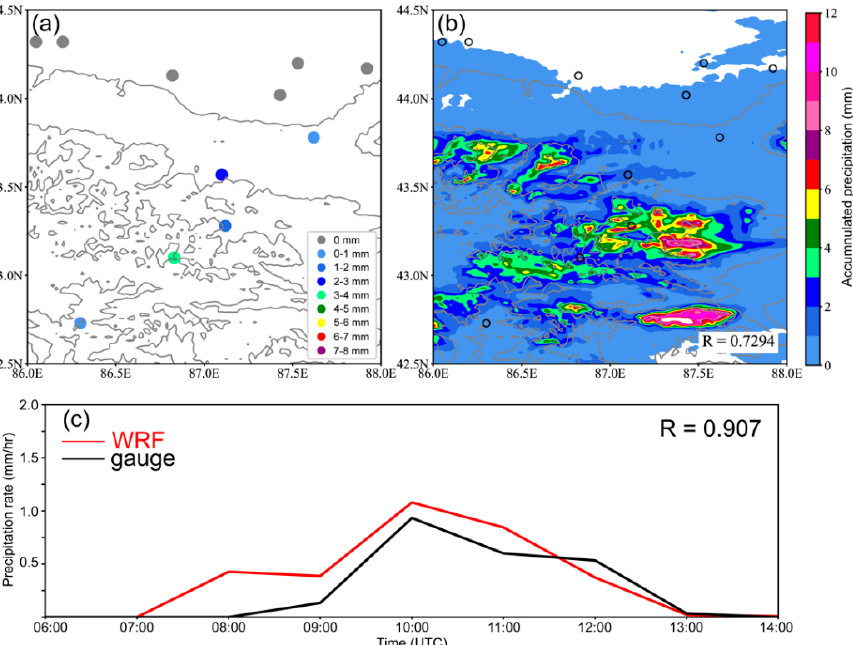
Figure 11. Map of accumulated precipitation ( a ) measured by rain gauges and ( b ) modeled by WRF. The black circles in ( b ) indicate the locations of rain gauges; ( c ) Time series of the average precipitation rate at the three stations over the north slope near the observational site.